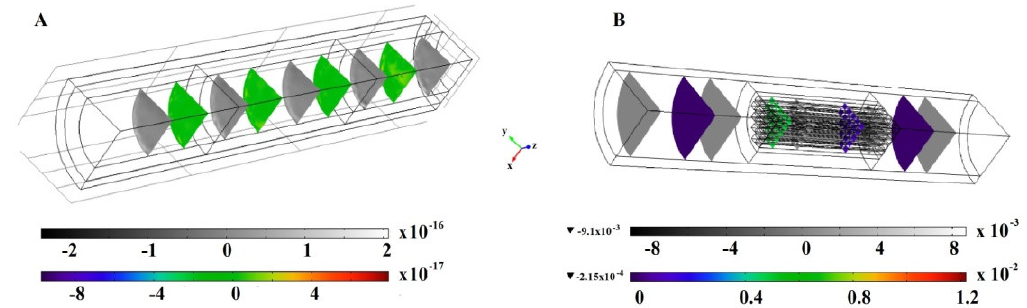
Figure 10. Mass flux (mol/m 2 /s) components in the axial direction (colored scale) and radial direction (grey scale), in the 3D simulation domain: PtCeWF10 ( A ) and PtCeWM ( B ).